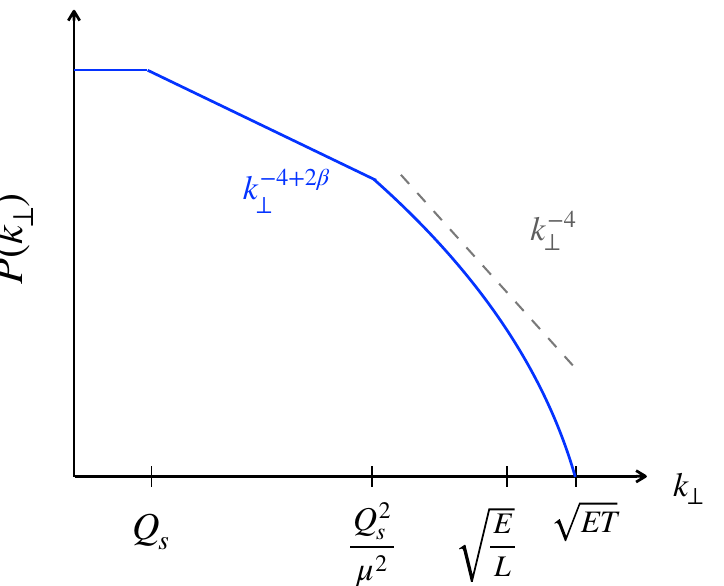
Figure 11. An illustration of the various regimes of the transverse momentum broadening distri- √ bution P ( k ⊥ ) . In the non-linear regime k ⊥ . Qs = ˆ qL the distribution is dominated by multiple soft scattering and the distribution exhibits geometric scaling, i.e., it is only a function of the scaling variable k ⊥ /Q s . The regime Q s . k ⊥ . Q 2 /µ corresponds the extended geometric scaling window s that is characterized by a heavy tailed distribution. For k ⊥ > Q 2 /µ the dynamics is linear and thus, s p not sensitive to saturation physics. k ⊥ = E/L scale marks the transition from k − ≡ xP − ∼ 1 /L to k − ≡ xP − ∼ k 2 / 2 E . The latter relates to the standard Feynman x of the medium ⊥